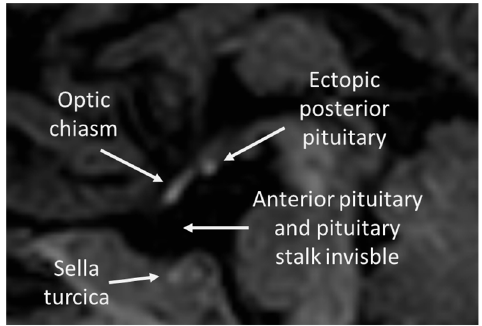
Figure 1. Typical features of PSIS in Patient’s 1 MRI (sagittal plain).